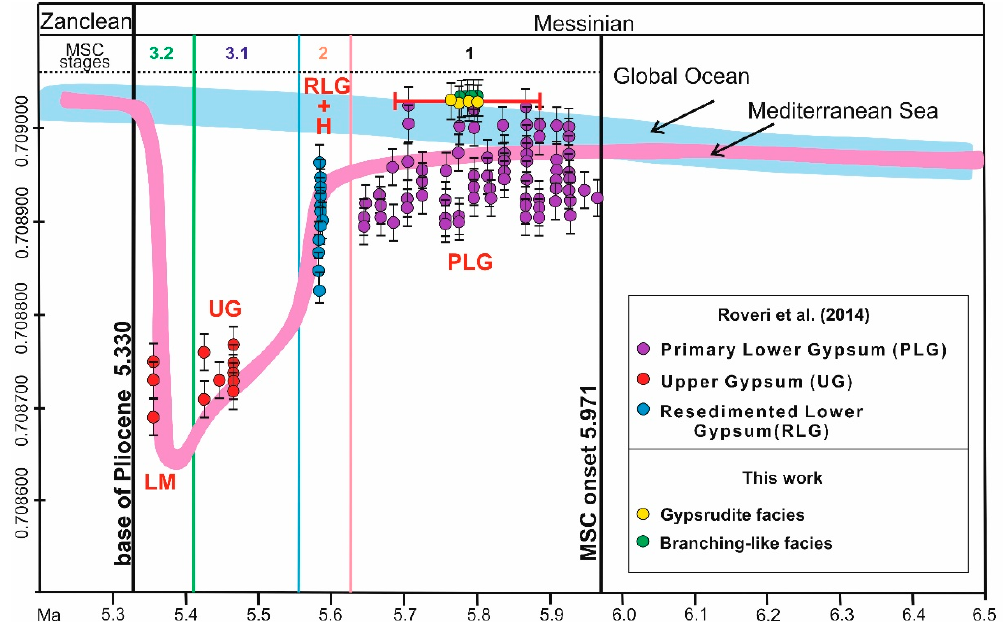
Figure 6. Sr isotope curve in the Mediterranean Sea and Global Ocean during the Messinian age. The distribution documents the progressive change in the isotopic composition of Mediterranean waters during the Messinian salinity crisis. The 87 Sr/ 86 Sr value obtained in samples from the gypsrudite (yellow circles) and branching-like facies (green circles) fall in the field of the Primary Lower Gypsum and they are comparable with samples collected in outcrop by Roveri et al. [11]; PLG: Primary Lower Gypsum; H: Halite; RLG: Resedimented Lower Gypsum; UG: Upper Gypsum; LM: Lago Mare. Figure modified from Roveri et al. [11].